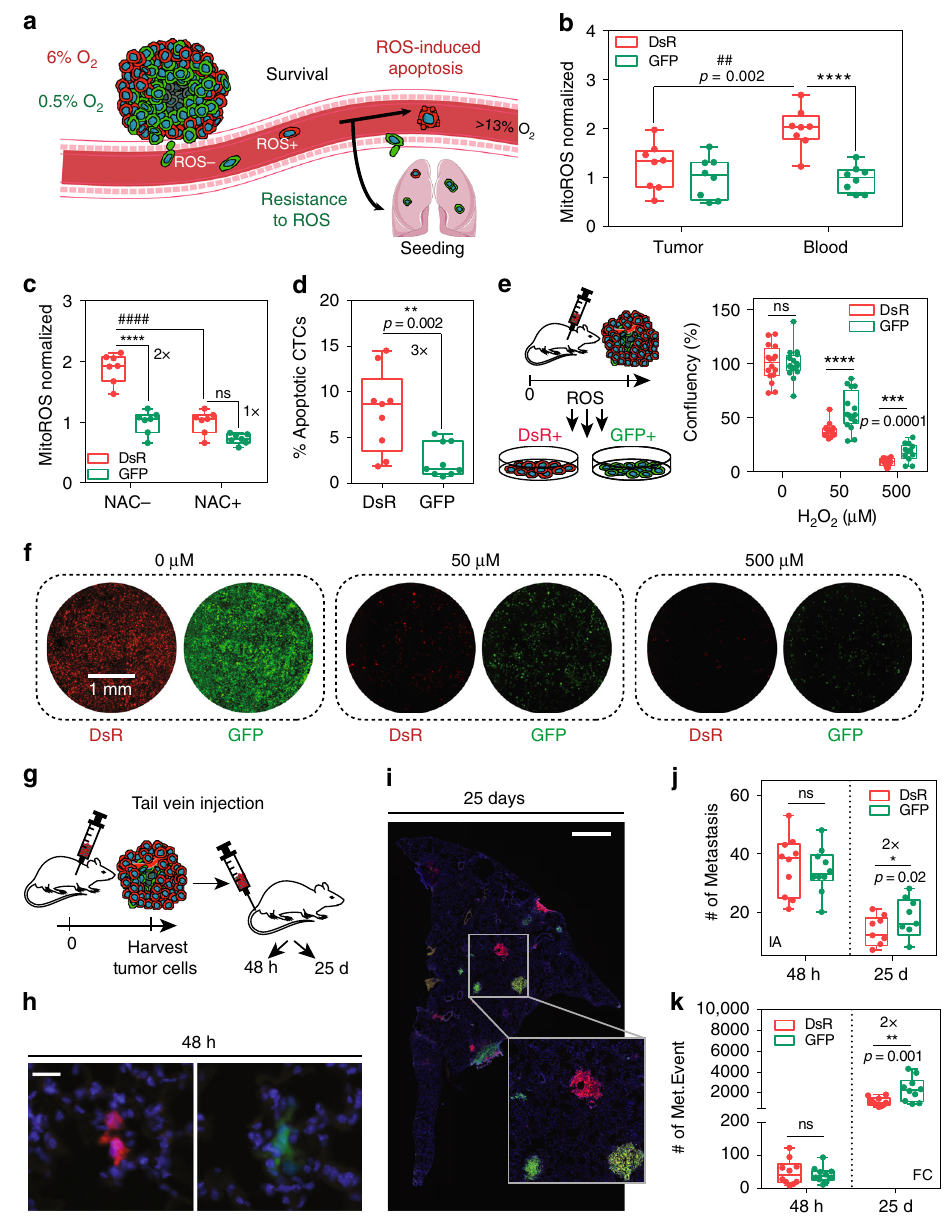
Fig. 8 Post-hypoxic CTCs have ROS-resistant phenotype. a Schematic representation of the proposed mechanism. Post-hypoxic cells (GFP + ) are resistant to ROS and have a survival advantage over DsRed + cells in the bloodstream. b Mitochondrial ROS levels were measured by using MitoROS by fl ow cytometry in matched tumor and blood samples freshly harvested from mice ( N = 2, n = 8); **** P < 0.0001 GFP versus DsRed and #### P < 0.0001 tumor versus blood (Two-way ANOVA with Bonferroni posttest). The box extends from the 25th to 75th percentiles, the median is the vertical line inside the box, and the whiskers represent the minimum and maximum. c Freshly isolated CTCs were treated with the ROS inhibitor N-acetylcysteine (NAC) for 1 h, and ROS levels were measured using MitoROS by fl ow cytometry ( N = 1, n = 7); **** P < 0.0001 GFP versus DsRed and #### P < 0.0001 NAC – versus NAC + (Two-way ANOVA with Bonferroni posttest). d Cell viability was measured by using Sytox Blue by fl ow cytometry ( N = 1, n = 9); **** P < 0.0001 GFP versus DsRed (two-tailed t -test). e , f Tumor-derived cells sorted for DsRed + or GFP + expression were treated ex vivo with H 2 O 2 for 1 h and f were quanti fi ed 48 h later by image analysis by using nuclei segmentation to determine cell con fl uence ( e ) ( N = 4, n = 16); **** P < 0.0001 GFP versus DsRed (Two-way ANOVA with Bonferroni posttest). g Tumor-derived hypoxia fate-mapping cells (1 × 10 5 cells) were injected directly into the tail vein of NSG mice. Organs were harvested either 48 h or 25 days after injection. h , i Cryo-sections of the lung were stained with DAPI and imaged for DsRed and GFP to detect micrometastasis after 48 h ( h ) or macrometastasis after 25 days ( i ). Scale bar: 50 μ m ( h ), 1 mm ( i ). j Quanti fi cation of the number of metastatic events by image analysis of mounted lung sections after 48 h or 25 days ( N = 1, n = 9 – 10); **** P < 0.0001 GFP versus DsRed (Two-way ANOVA with Bonferroni posttest). k Quanti fi cation of metastatic burden by fl ow cytometry analysis of lungs after 48 h or 25 days ( N = 1, n = 10); **** P < 0.0001 GFP versus DsRed (Two-way ANOVA with Bonferroni